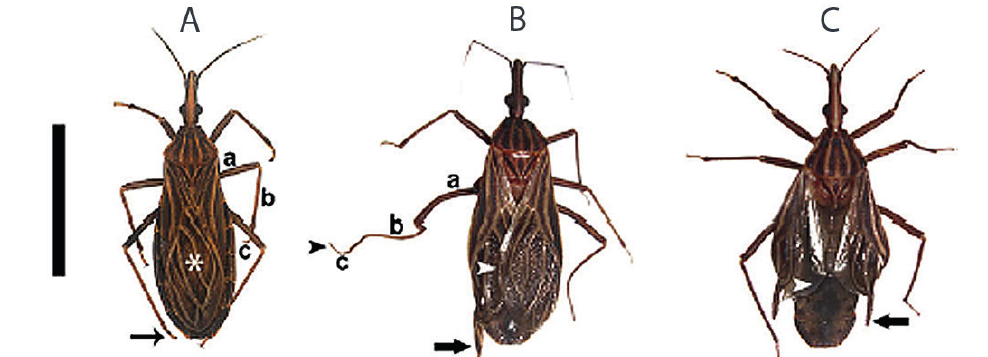
Figure 3 - Malformation of adult males of Rhodnius prolixus after continuous treatment with Z. caribaeum essential oil. (A) Normal legs of control insects (arrow), normal wings (asterisk). (B) and (C) Short wings (white arrowhead) and deformed (broad black arrow). elongated legs (black arrowhead). Femur ( a ), tibia ( b ) and tarsus ( c ). Insect (B) shows an absence of the left glaw. (Nogueira et al. 2014a). The bar is equal to